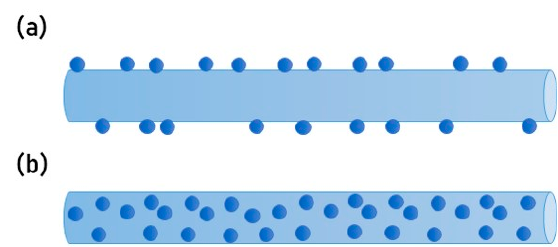
Figure 3. Schematic of fibre functionalisation with HA-CS nanoparticles as ( a ) surface modification or ( b ) blend.